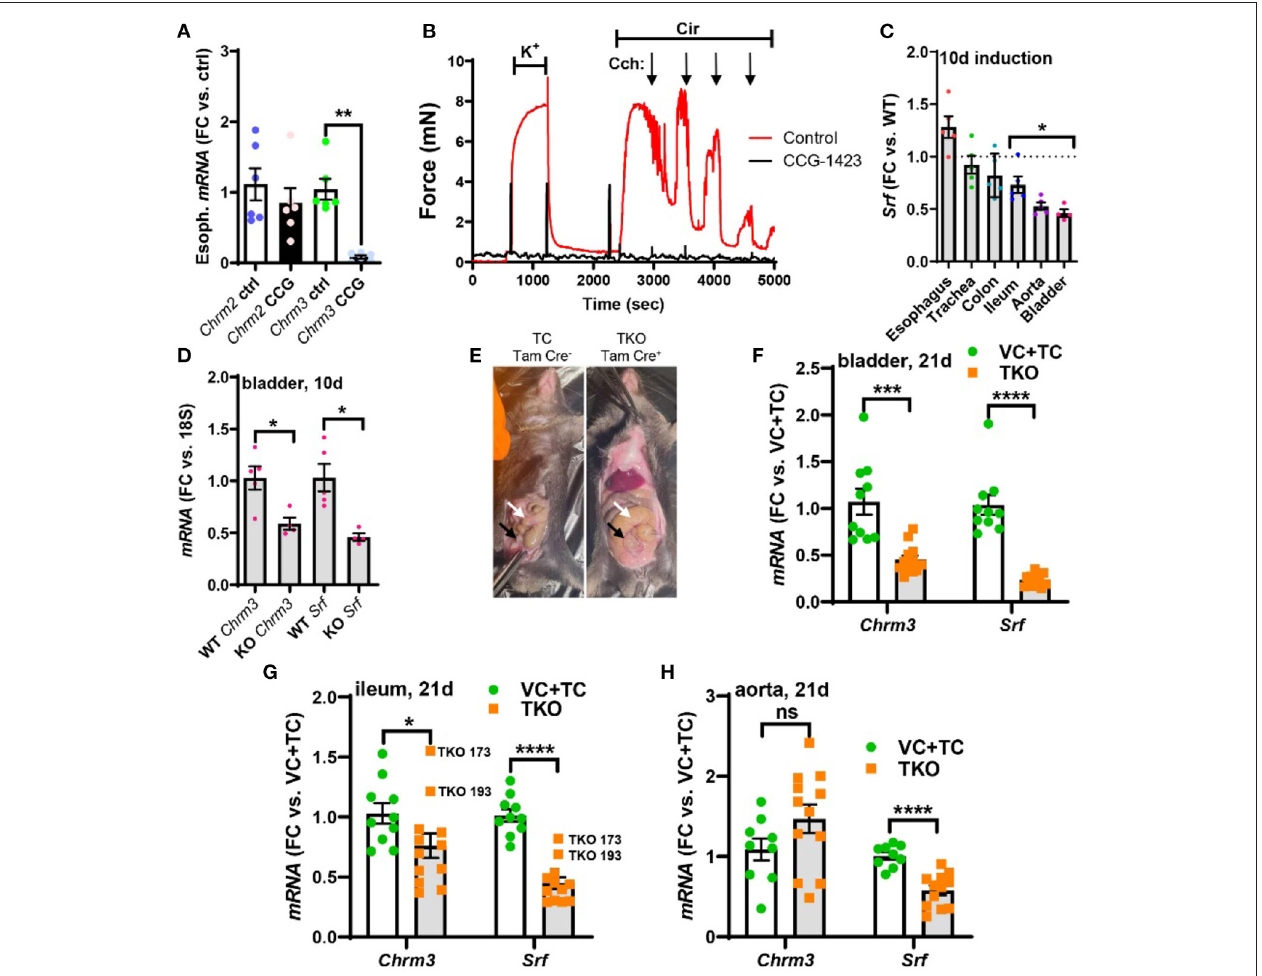
FIGURE 5 | Pharmacological inhibition of MRTF-SRF signaling in organ culture, and knockout of Srf in vivo , reduces M3 receptor expression. To examine if MRTF-SRF signaling regulates muscarinic M3 receptor expression in situ , we first isolated organs from wild-type C57Bl/6 mice. Organs were split in half and maintained for 96h in organ culture with vehicle (DMSO) or CCG-1423 (10 µ M). A clear reduction of Chrm3 relative to the house-keeping gene 18 s was seen in the esophagus (A) , but in the remainder of the organs, the house-keeping genes examined declined (not shown). We also found that organ culture of the mouse caudal artery in the presence of CCG-1423 eliminated force development on stimulation with the α 1-adrenergic agonist cirazoline (B) , suggesting that this experimental paradigm is unsuitable for studying effects on endothelium-dependent dilatation. Mice with SMC-specific knockout of Srf were next obtained by injecting Srffl/fl mice harboring the Myh11-Cre/ERT2 transgene with tamoxifen for 5 consecutive days (knockout: KO). Cre-negative Srffl/fl mice injected with tamoxifen were used as controls (wild-type: WT). Organs were harvested and frozen 10 days after the first injection and transcript levels were determined by RT-qPCR. At this time, body weights were unchanged, but Srf depletion was seen in some organs (C) . (D) Shows that Chrm3 was reduced in parallel with Srf in the bladder, but this was not seen elsewhere (not shown). We therefore next used mice at 21 days post tamoxifen. Two control groups were included in this second experiment along with the tamoxifen-treated knockouts (TKO): vehicle-treated Cre-positive mice (VC) and tamoxifen-treated Cre-negative mice (TC). At 21 days, mobility on provocation was reduced, the intestines had started to swell [ (E) , white arrows], and the urinary bladders were often enlarged [ (E) , black arrows]. Both Chrm3 and Srf were reduced in the bladder (F) and ileum (G) . For the ileum, the two knockouts with the most modest Srf depletion (TKO 173 and TKO 193) are highlighted. No change of Chrm3 was seen in the aorta (H) , despite significant Srf depletion. These findings show that MRTF-SRF signaling is critical for Chrm3 expression in gastrointestinal and urogenital organs in vivo . *** p < 0.001, ** p < 0.01, and * p < 0.05.